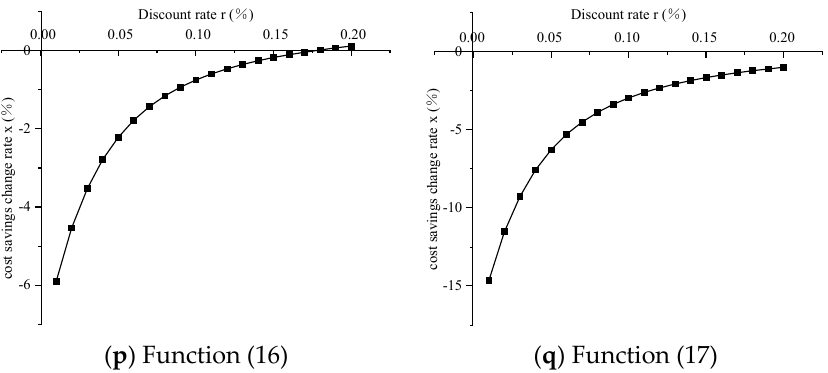
Figure 10. Two-factor sensitivity incremental cost and discount rate analysis graph. Table 7. Table of limiting values of the corresponding cost savings change rates at different discount rates.